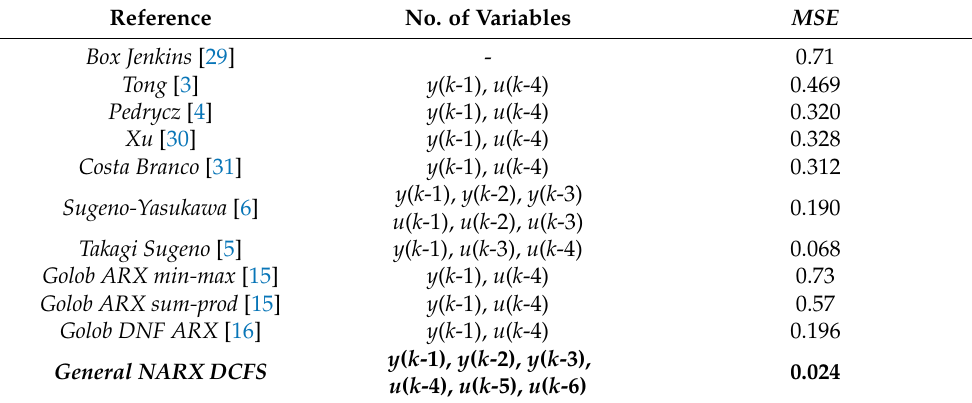
Table 3. Identification results for the Box–Jenkins gas